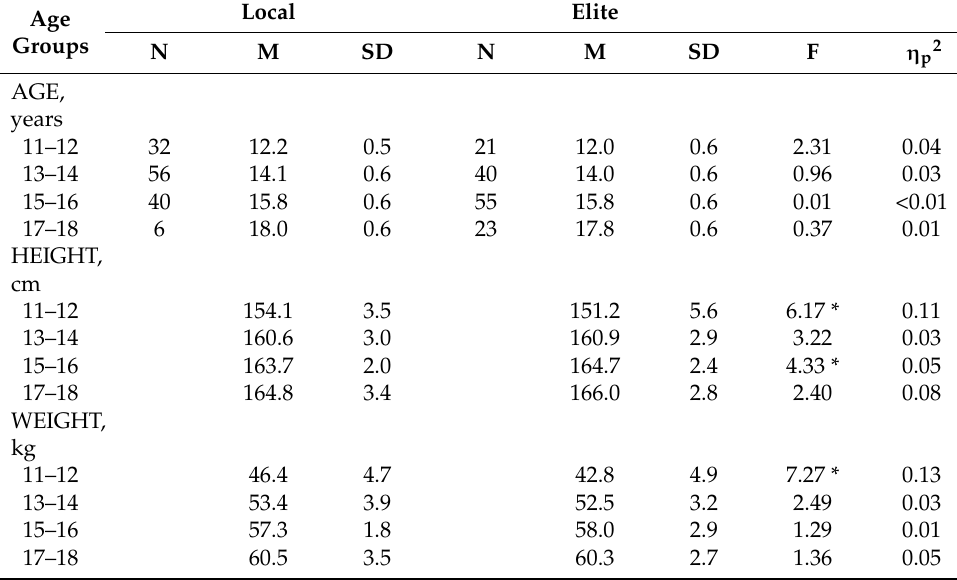
Table 2. Number of data points (N), means (M) and standard deviations (SD) based on means for the age, height and weight of female soccer players classified as local or elite in four chronological age groups, results of age-group-specific ANCOVAs controlling for the year of study, and effect sizes. Age Groups